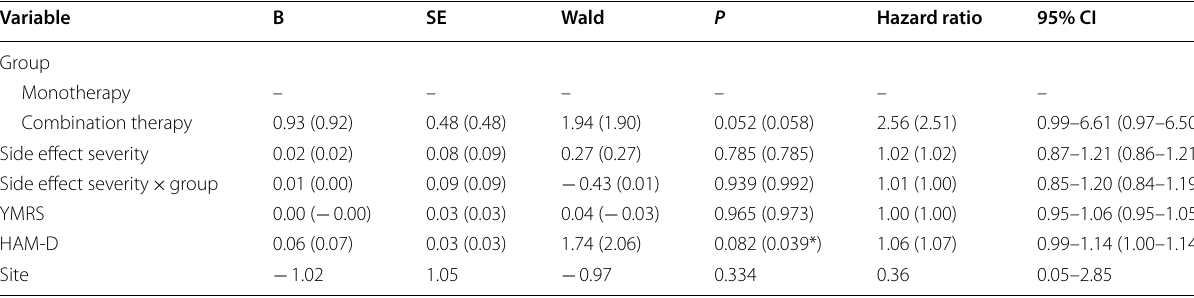
Estimates for the model that excluded site are shown in parentheses Monotherapy: divalproex plus placebo; combination: combination therapy of divalproex plus blinded lithium and divalproex plus blinded